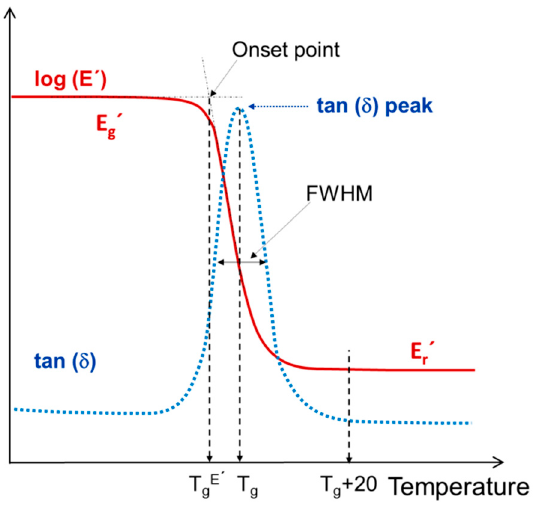
Figure 1. Schematic representation of the relevant parameters obtained from DMA analysis: storage modulus ( E ′ ) and tan δ curve for a typical thermoset. The parameters of interest have been pointed out. According to the Affine model for ideal rubbers, the relaxed modulus E r ′ at low strain rates is related to the strand density of the crosslinked network by Equation (1).